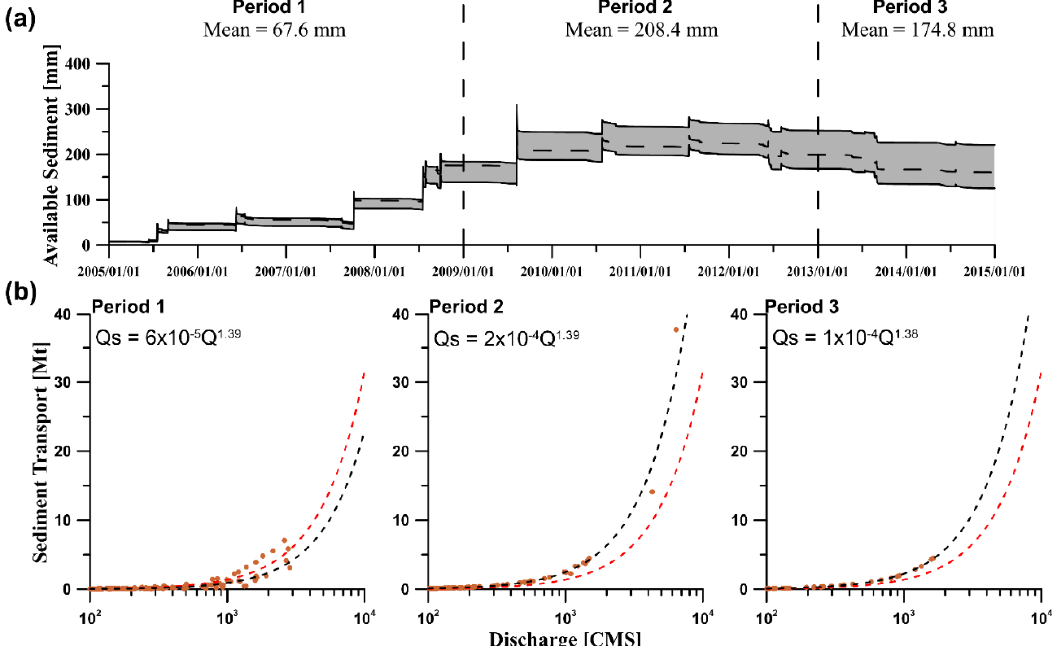
Figure 9. ( a ) Simulated time-series sediment storage (mm), and ( b ) the rating curves of simulated sediment discharge (Mt) against river runoff (m 3 s − 1 ) for the three periods. The gray zone in ( a ) is the envelope derived from the 23 non-inferior parameter sets. In ( b ), the black dashed curves represent the rating curve for each period, and the red dashed curves are reference curves and remain identical in the three panels.